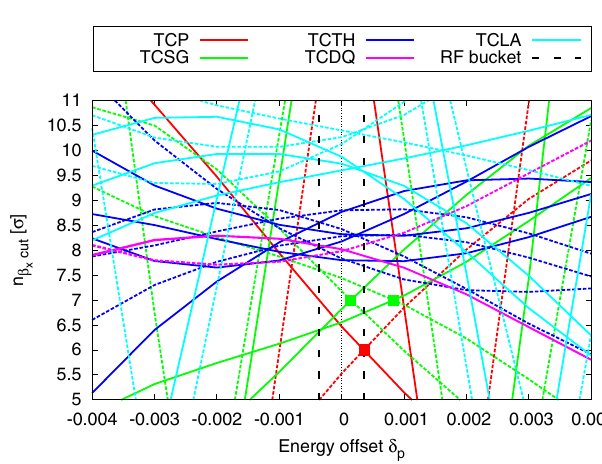
FIG. 12. (Color) Zoomed view of Fig. 11 (top left), longitudinal slice with z ¼ 1 (cid:7) z .